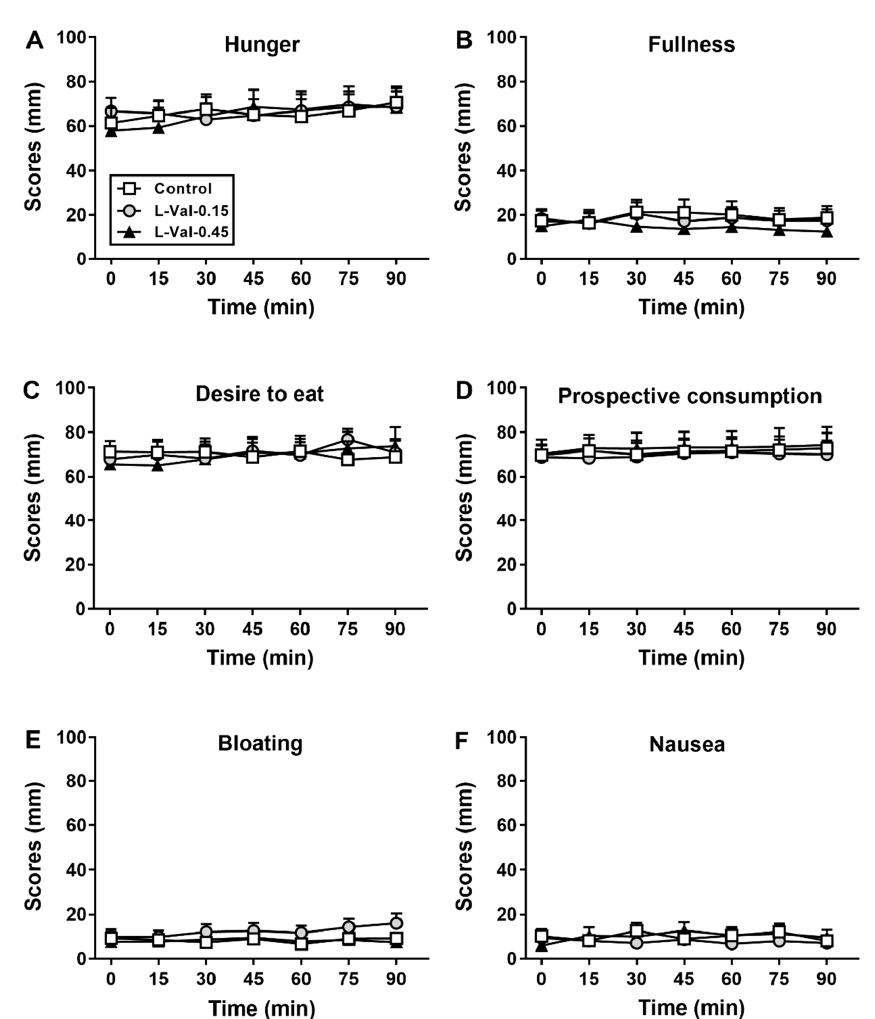
Figure 2. Scores for hunger ( A ), fullness ( B ), desire to eat ( C ), prospective consumption ( D ), bloating ( E ) and nausea ( F ) during 90-min intraduodenal infusions of L-valine at 0.15 kcal/min (“L-Val-0.15”) or 0.45 kcal/min (“L-Val-0.45”), or control. Repeated-measures two-factor ANOVA, with